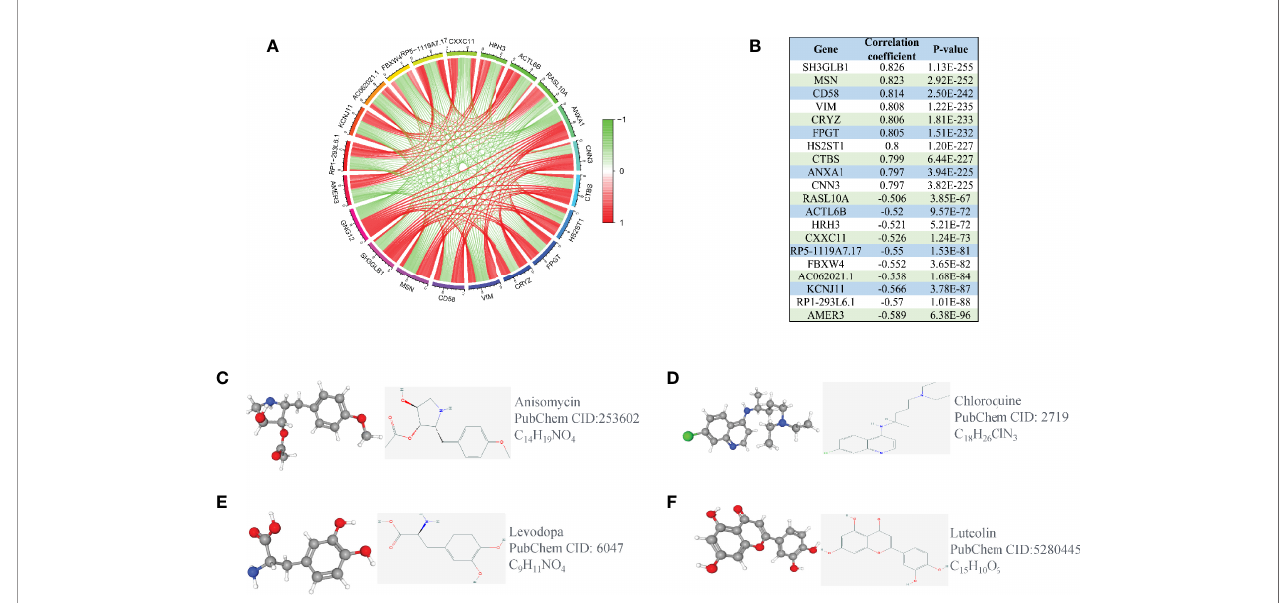
FIGURE 5 | Co-expression analysis of GNG12. (A) The ten most signi fi cant genes of positive and negative correlating with GNG12; (B) The correlation coef fi cients and P values of the ten most important positive and negative genes related to GNG12. Screening of gene therapy drugs for GNG12 in the CMap and PubChem database (Drug name, chemical structure, 2D structure, 3D structures). (C) Anisomycin (D) Chloroquine (E) Levodopa (F)